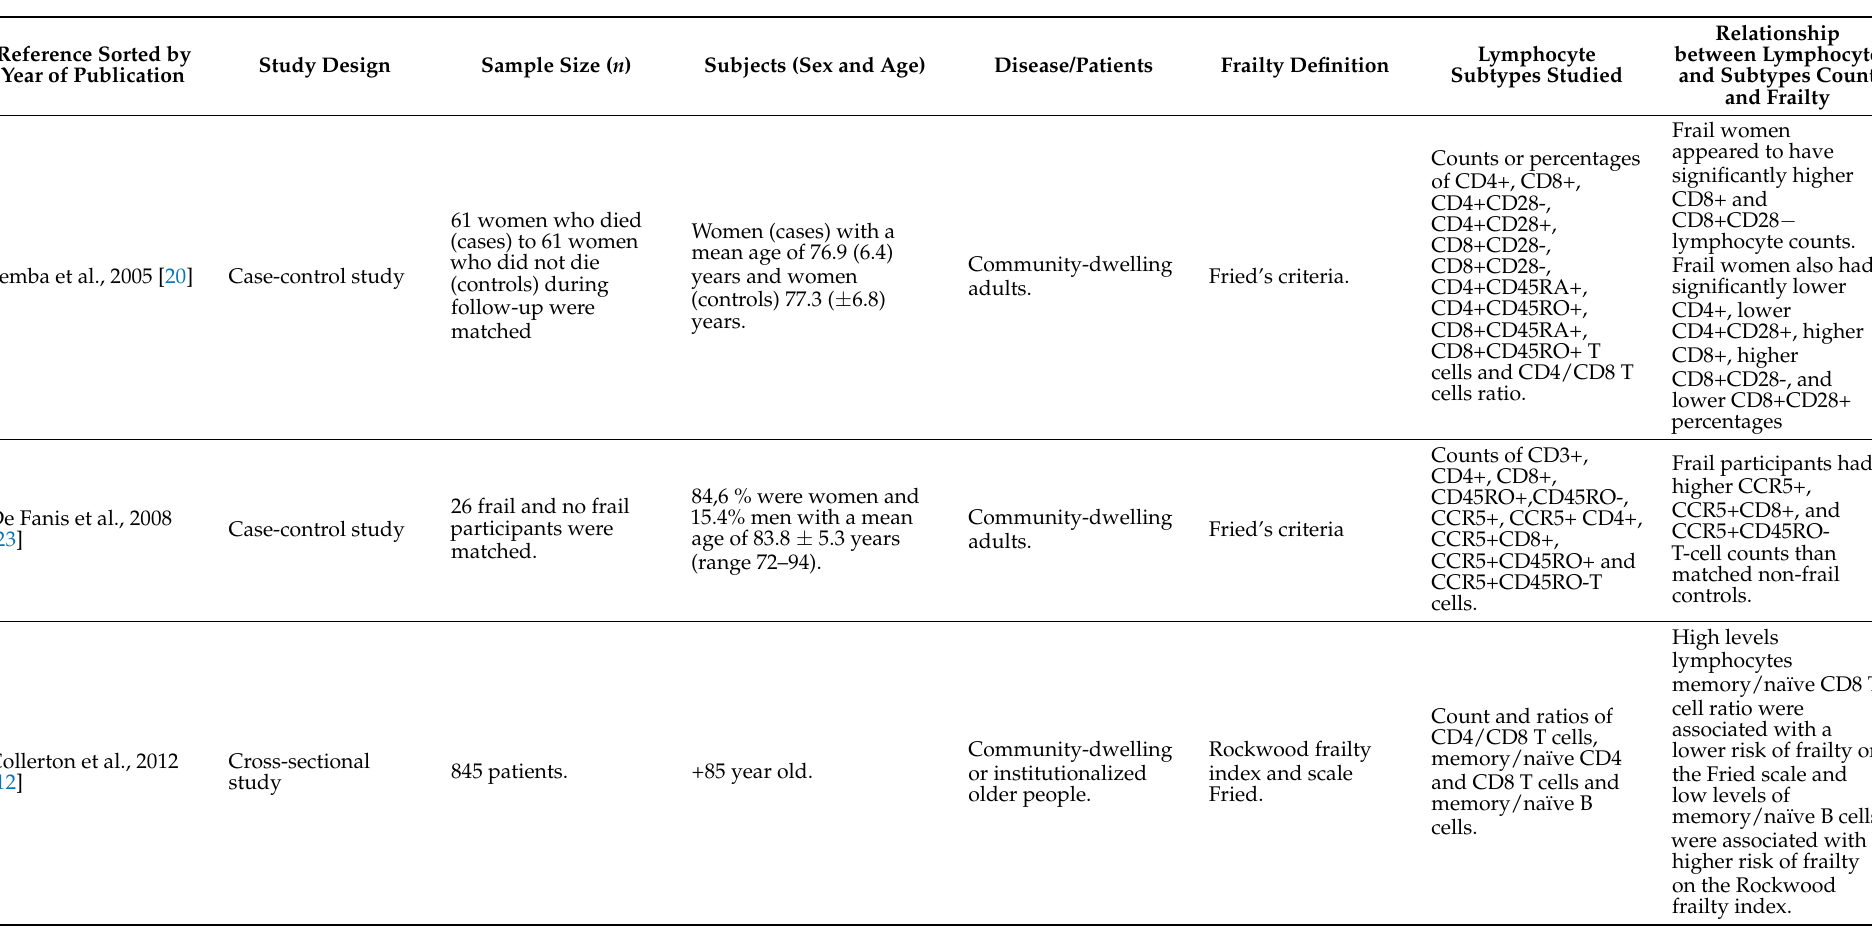
Table 2. Lymphocyte subtypes and their relationship with